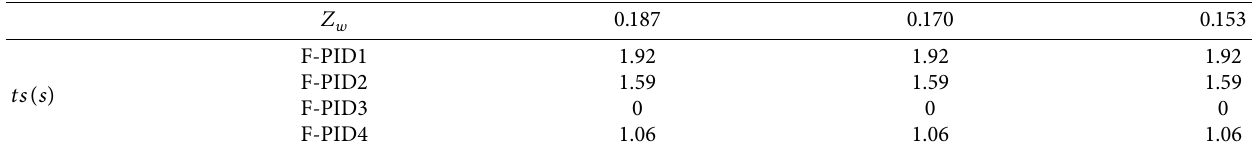
Table 9: Regulation time changes with the hydrodynamic